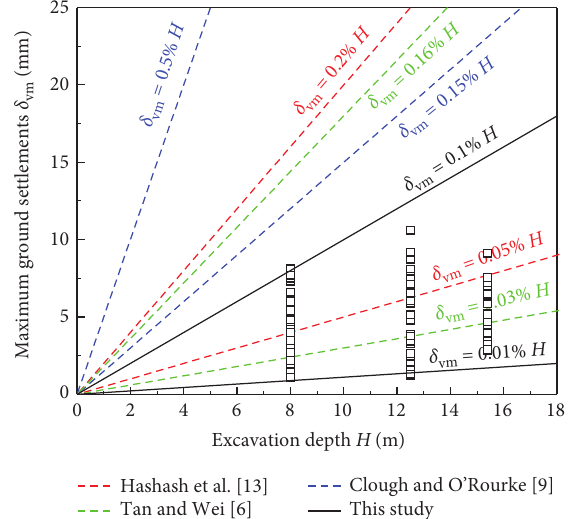
Figure 17: Relationship between the maximum ground settlement and the excavation